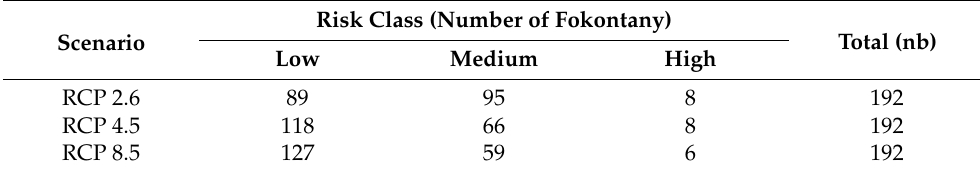
Table 6. Number of Fokontany in Analamanga region at risk